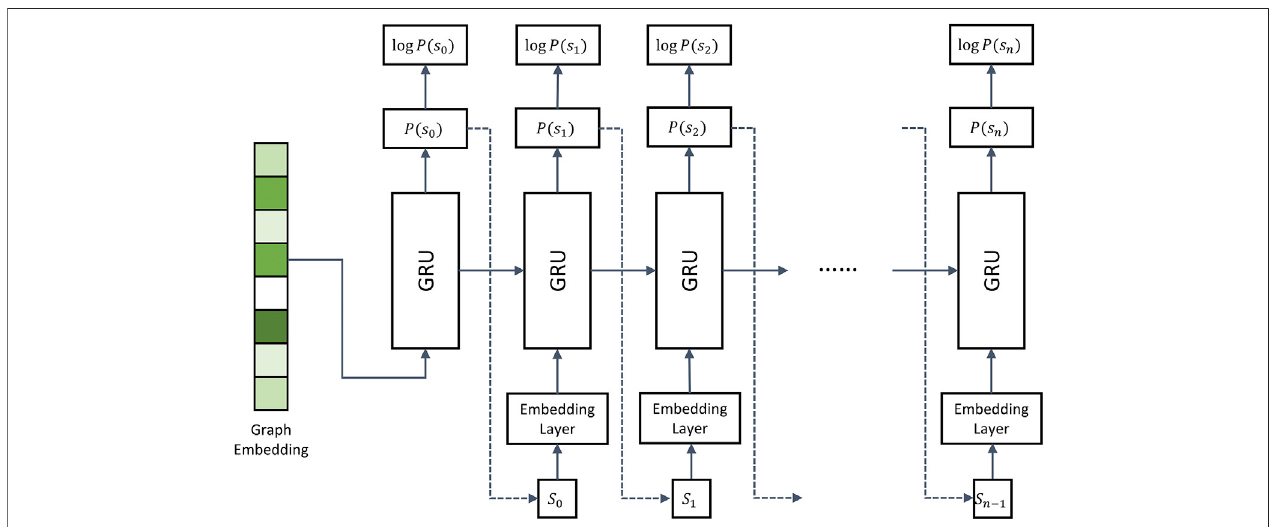
FIGURE2| Architectureoftherecurrentneuralnetworkdecoder. Thedecoderemploysmultiplegatedrecurrent units(GRUs).Duringmodeltraining,themolecule strings of binding drugs are used as the input. Dashed arrows represent the inference stage, in which the token sampled from P ( s t − 1 ) is used as the input at iteration t .